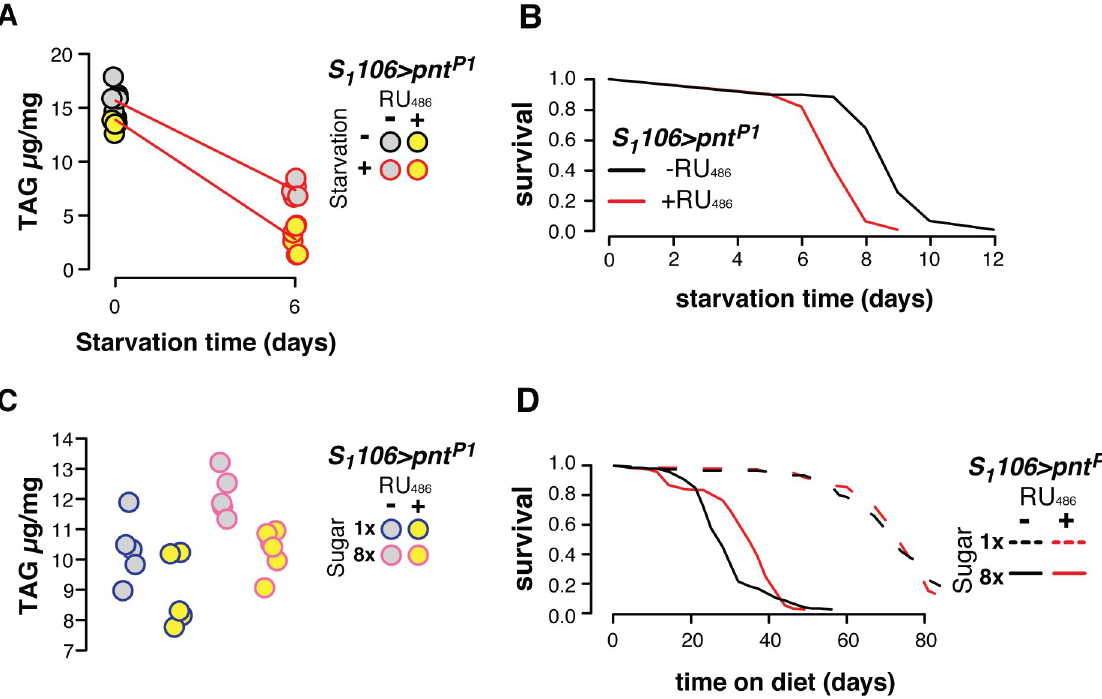
Fig 5. Pnt impacts the response to nutritional stress. (A) Over-expressing Pnt P1 in the gut and fat body accelerates loss of TAG under starvation stress (linear model: RU 486 :starvation F 1,19 = 7.03, p = 0.02; see S4 Fig for corresponding plot of body mass). (B) Over-expressing Pnt P1 in the gut and fat body reduces survival under starvation stress (log-rank test p = 1.3e-14). (C) Over-expressing Pnt P1 in the gut and fat body reduces accumulation of TAG on a high-sugar diet. Pnt P1 reduced TAG (linear model F 1,17 = 14.4, p = 1.4e-3), and sugar increased TAG (linear model: F 1,17 = 15.25, p = 1.1e-3), with Pnt P1 appearing to counteract the effect of sugar (mean ± SE: low sugar-RU 486 10.31 ± 0.48, high sugar+RU 486 10.30 ± 0.29; t-test t = 0.009, p = 0.99). (D) Over-expressing Pnt P1 in the gut and fat body enhances survival on a high-sugar diet (Cox Proportional Hazards diet:RU 486 p =